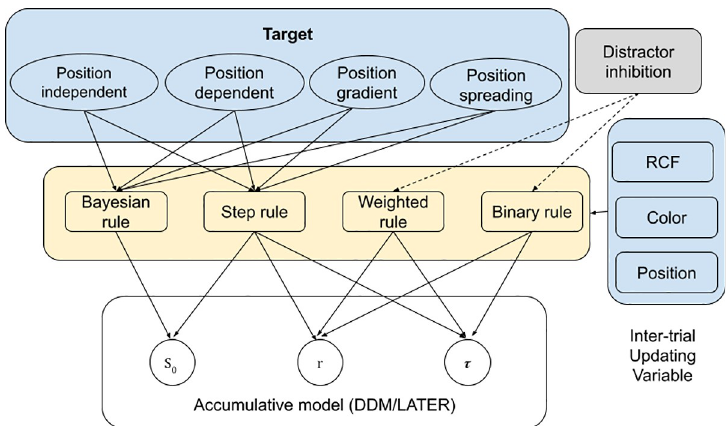
Fig 4. Illustration of the hierarchical modeling framework. Each hierarchical model consists of an evidence accumulation model (either the drift-diffusion model or the LATER model) and either no updating or one updating rule for each parameter of the evidence accumulation model (starting point S 0 , evidence accumulation rate r, and non- decision time τ ). Each updating rule belongs to one of the four categories shown in the middle layer of the figure, and is applied to one of the three inter-trial updating variables shown in the blue box on the right side of the figure: the response-critical feature (RCF), the target-defining color, or the target position. For some of the updating rules based on the RCF or color, there are three different versions of the rule, differing in their degree of position-specificity (top level of the hierarchy). These rules could be fully position-independent (PI), fully position-dependent (PD), with a gradient-like dependence on the change of position (PG), or starting out fully position-dependent but then spreading (PS). See the main text for detailed